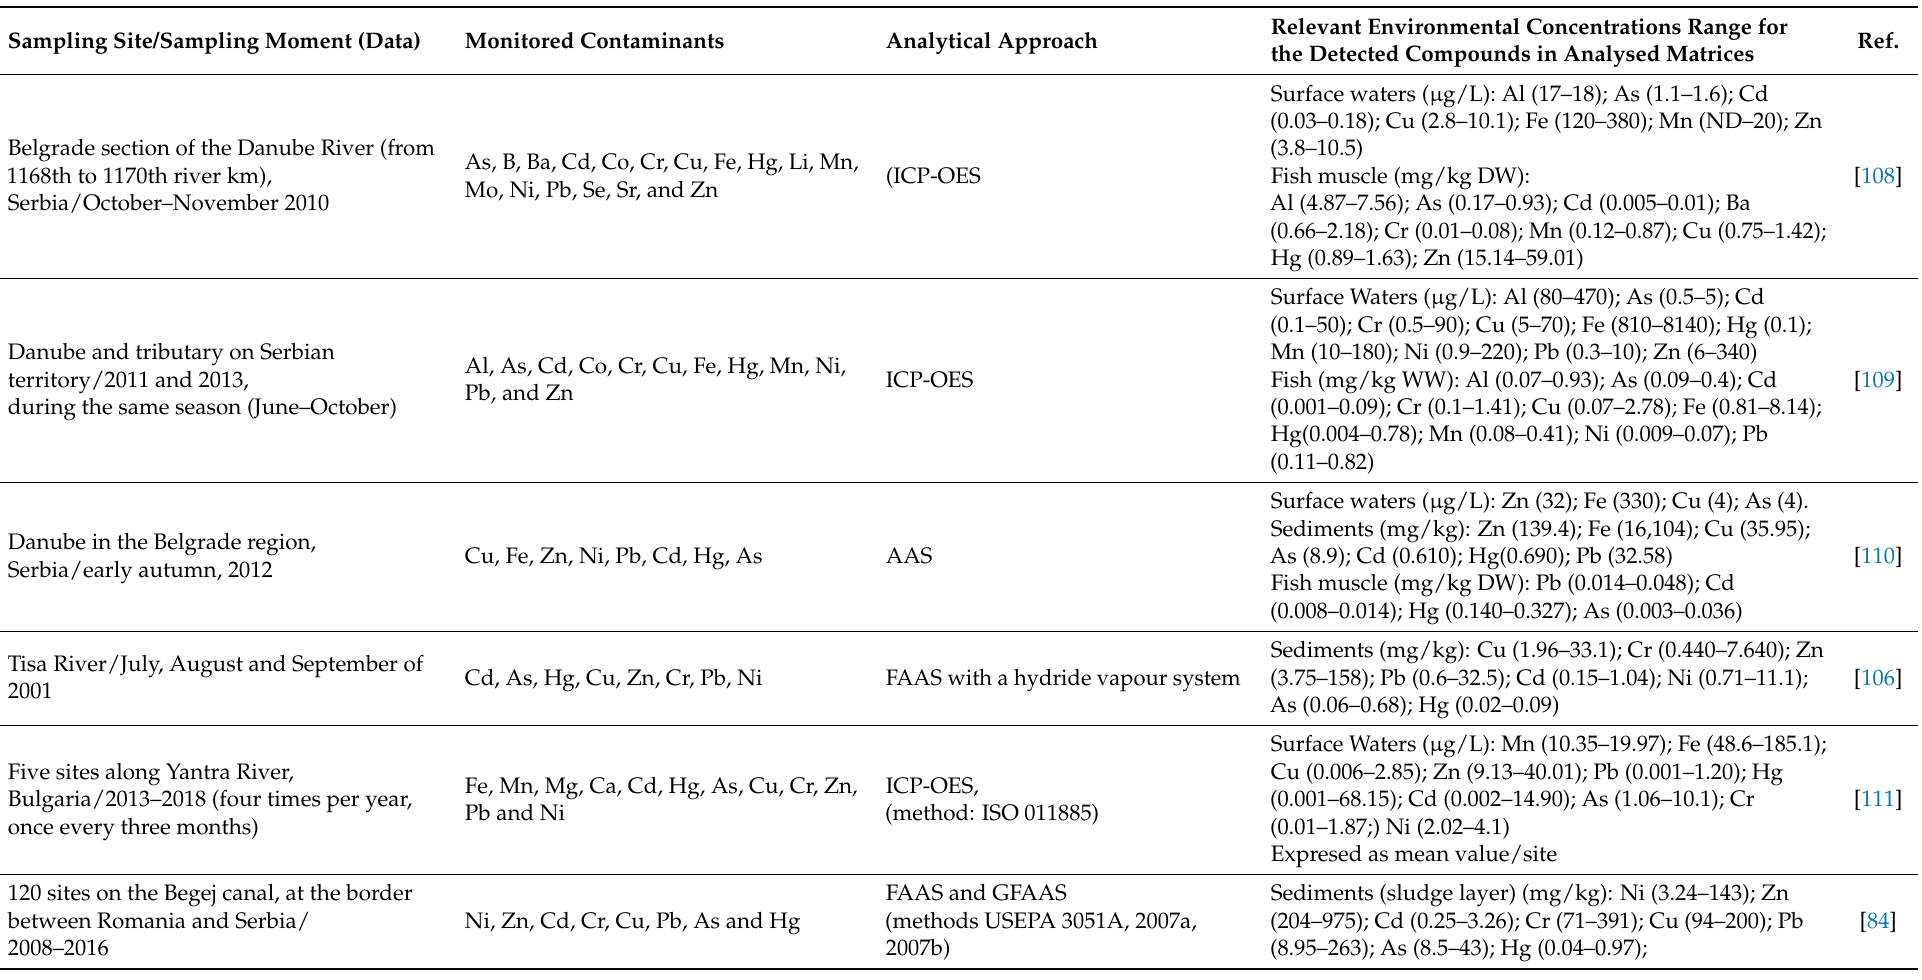
Table 5. Summary of selected publications during 2010–2021 on metal pollution in the area of Low Danube and North-West Black Sea